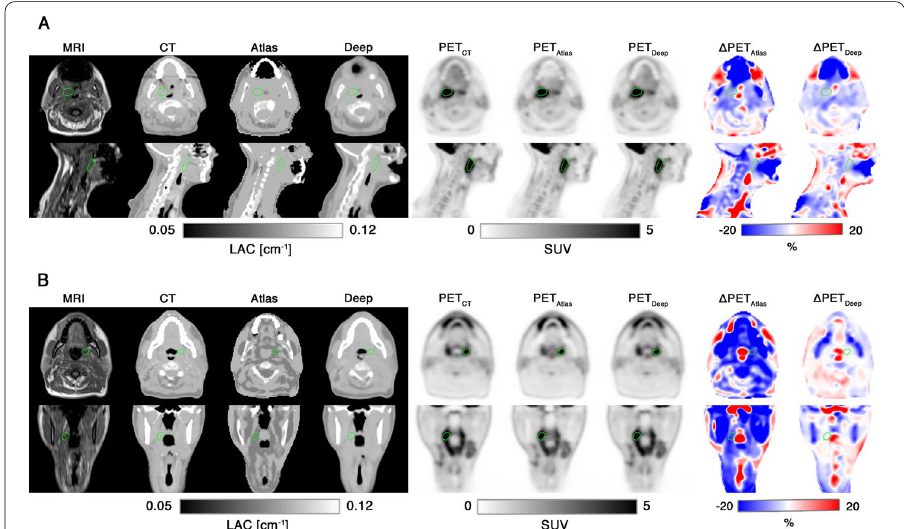
Fig. 6 The worst performing cases, based on tumor (green delineation) SUV mean error, for ( A ) the deep learning method (error of 4.1% for PET Deep and 6.7% for PET Atlas ) and for ( B ) the atlas-based method (error − − of 0.8% for PET Deep and 14.4% for PET Atlas ). ( A ) Axial and sagittal slices of a 68 year old female with cancer − − of the right tonsil and bilateral lymph node involvement (T3N2M0). The large single void in the MRI